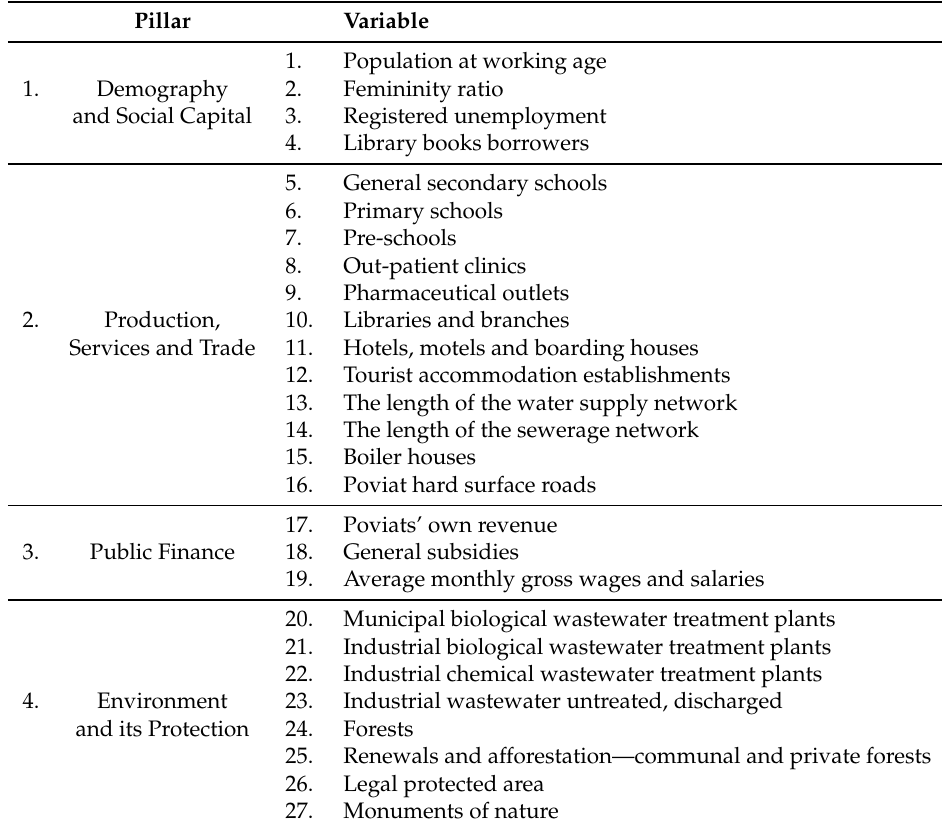
Table 2. List of the variables used in the research divided into